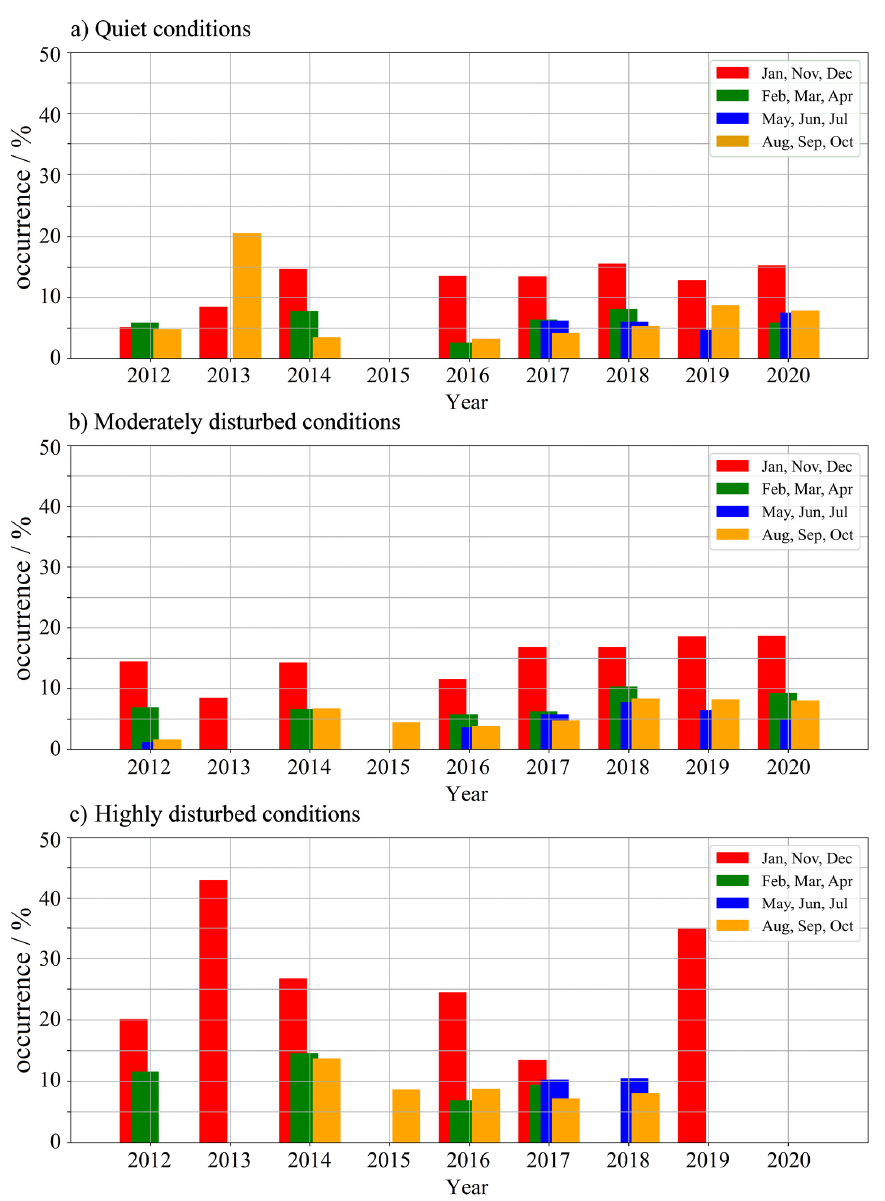
Figure 5. The occurrence of spread F as a function of different years, representing different levels of solar activity, during different periods of the year, and under different levels of geomagnetic activity: ( a ) quiet conditions, ( b ) moderately disturbed conditions, and ( c ) highly disturbed conditions. Only the histograms derived from more than 80 cases of spread F are shown.